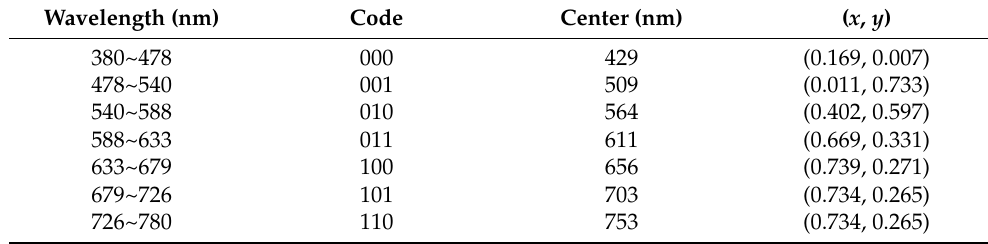
Table 4. CSK in code and chromaticity coordinates. © 2015 IEEE. Reprinted, with permission, from